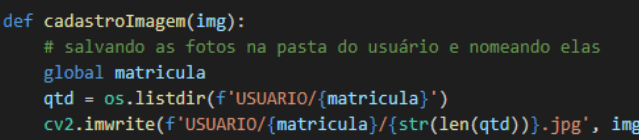
Figure 8: Registered users' information bank.